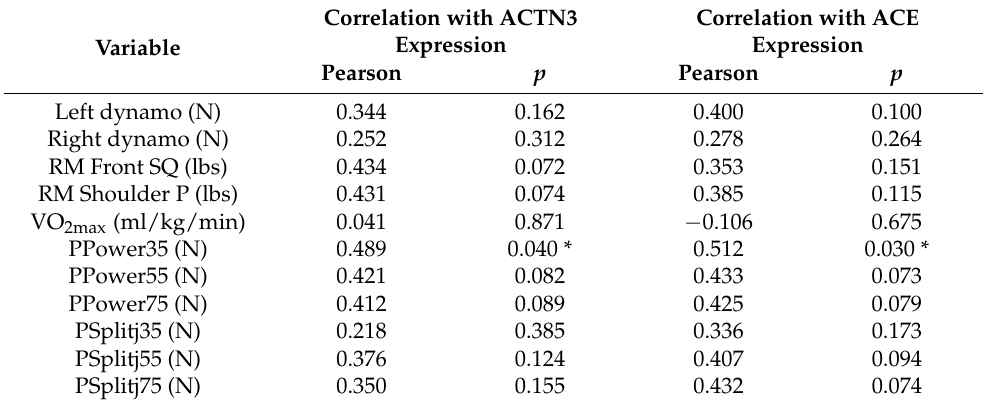
Correlation with ACE Expression